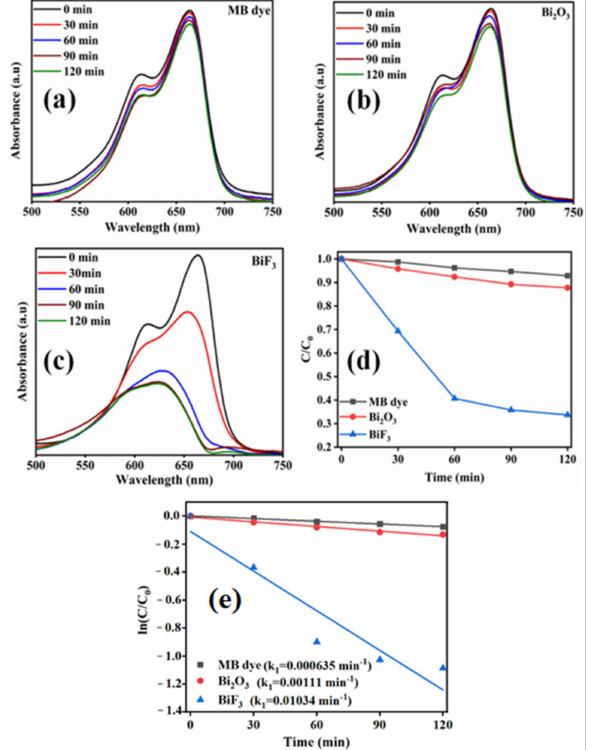
Figure 2. Absorption vs. wavelength spectra for ( a ) the photolysis of Methylene blue (MB), and the photocatalysis of MB under the exposure of UV light of 355 nm wavelength due to ( b ) Bi 2 O 3 powder and ( c ) BiF 3 powder ( d ) respective C/Co vs. time plots, and ( e ) ln(C/Co) vs. time plots to obtain the pseudo-first-order reaction rate constant for the photolysis of MB and the photocatalysis of